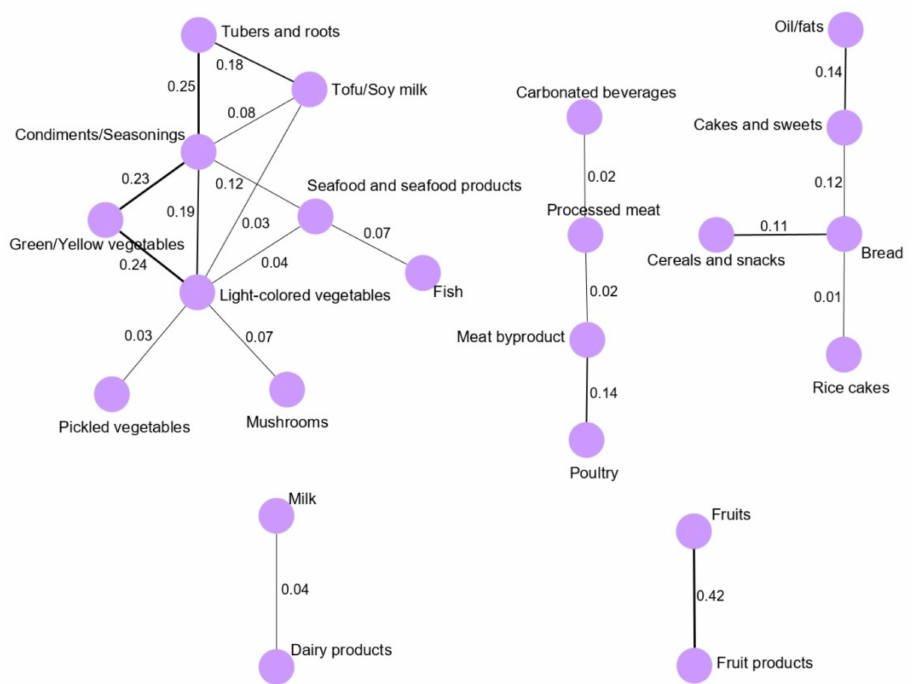
Figure 1. Dietary intake networks for the total study population derived from GGM. Nodes represent the food group variables, and edges represent the conditional dependencies reflected by partial correlation coefficients between food groups. The thickness of the edge is proportional to the strengths of the correlation between food groups. The absence of an edge between two food groups indicates conditional